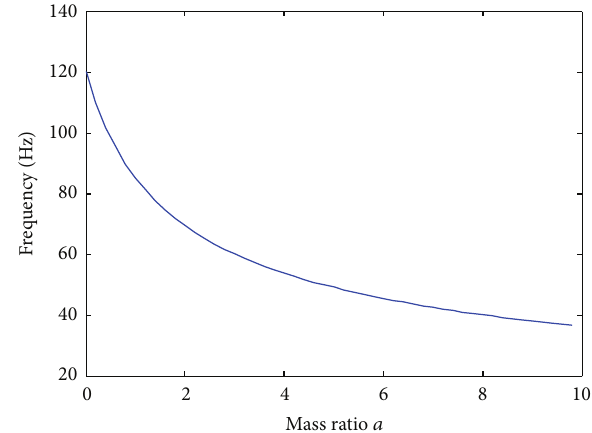
Figure 4: Variation in the resonance frequency of the PVEH with various mass ratios 𝑎 .